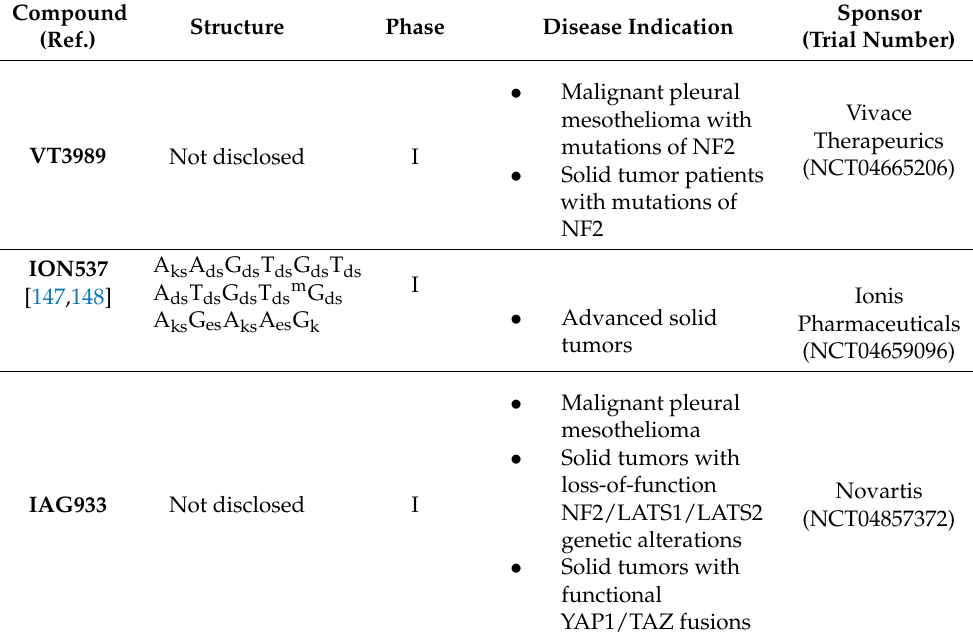
Table 2. Recently initiated clinical trials to inhibit TEAD-driven transcription in